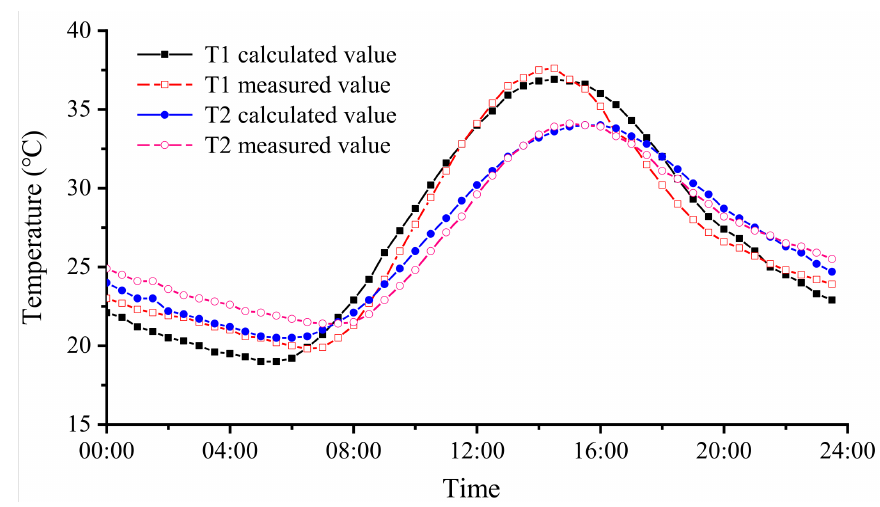
Figure 7. Comparison of thermodynamic analysis results with measured